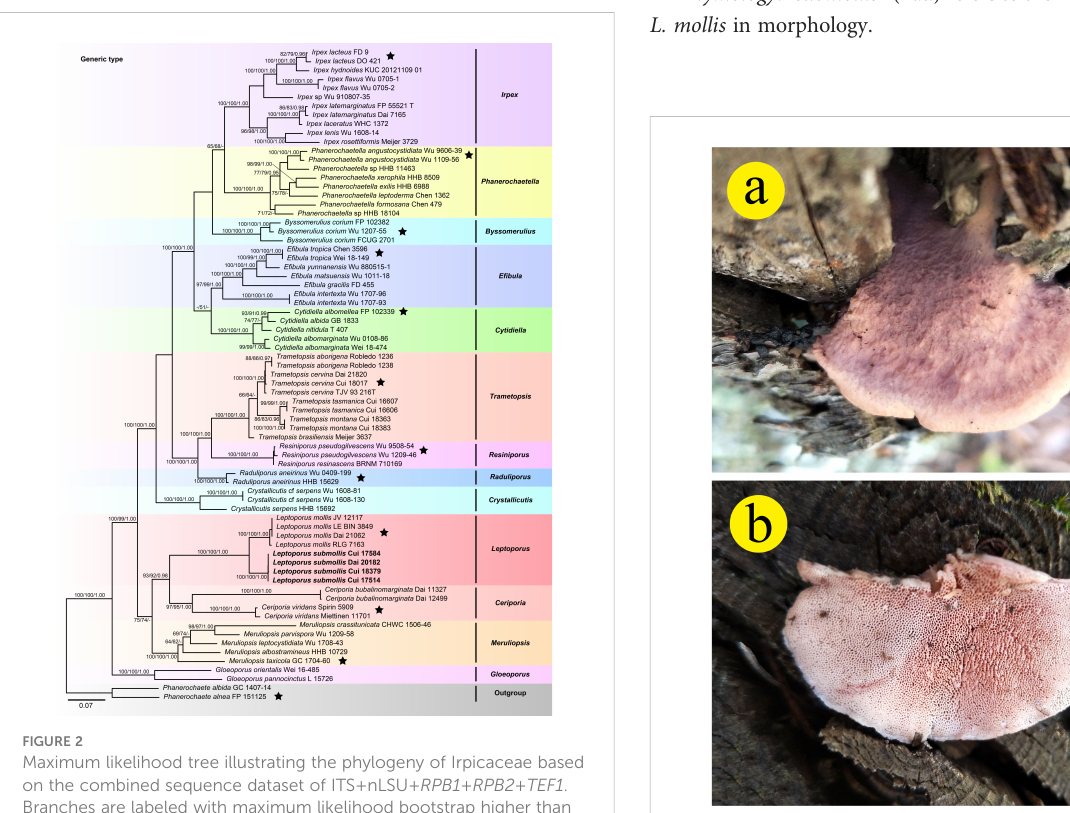
FIGURE 3 Basidiocarps of Leptoporus submollis ( Cui 17514 ) (scale bar = 1.5 cm). Photo by Bao-Kai